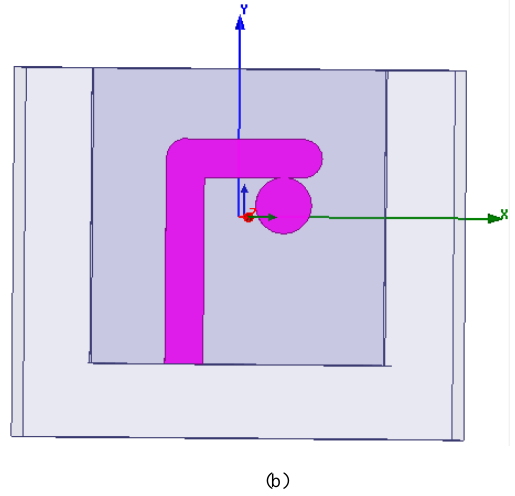
Fig1. Primary structure antenna, (a) on CST Microwave, (b) on HFSS.